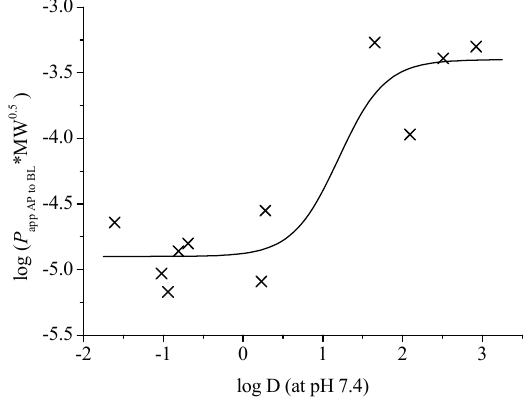
Figure 4. The relationship between the corrected permeability log ( P app AP → BL *MW 0.5 ) and log D (at pH 7.4) of the compounds 1 , 3 – 12 of